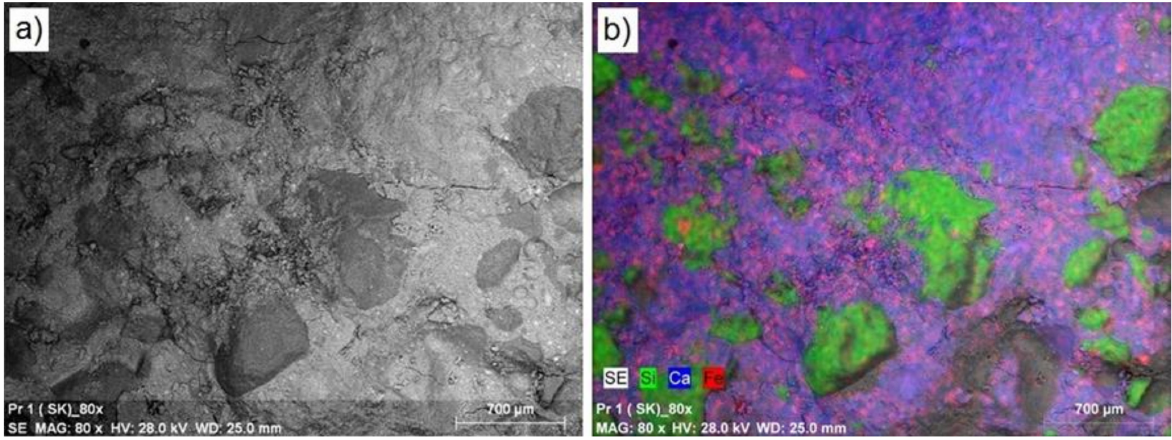
Figure 4. Microstructure of the controlled series concrete: ( a ) enlarged by 80 × ; ( b ) location map of the dominant elements in a given